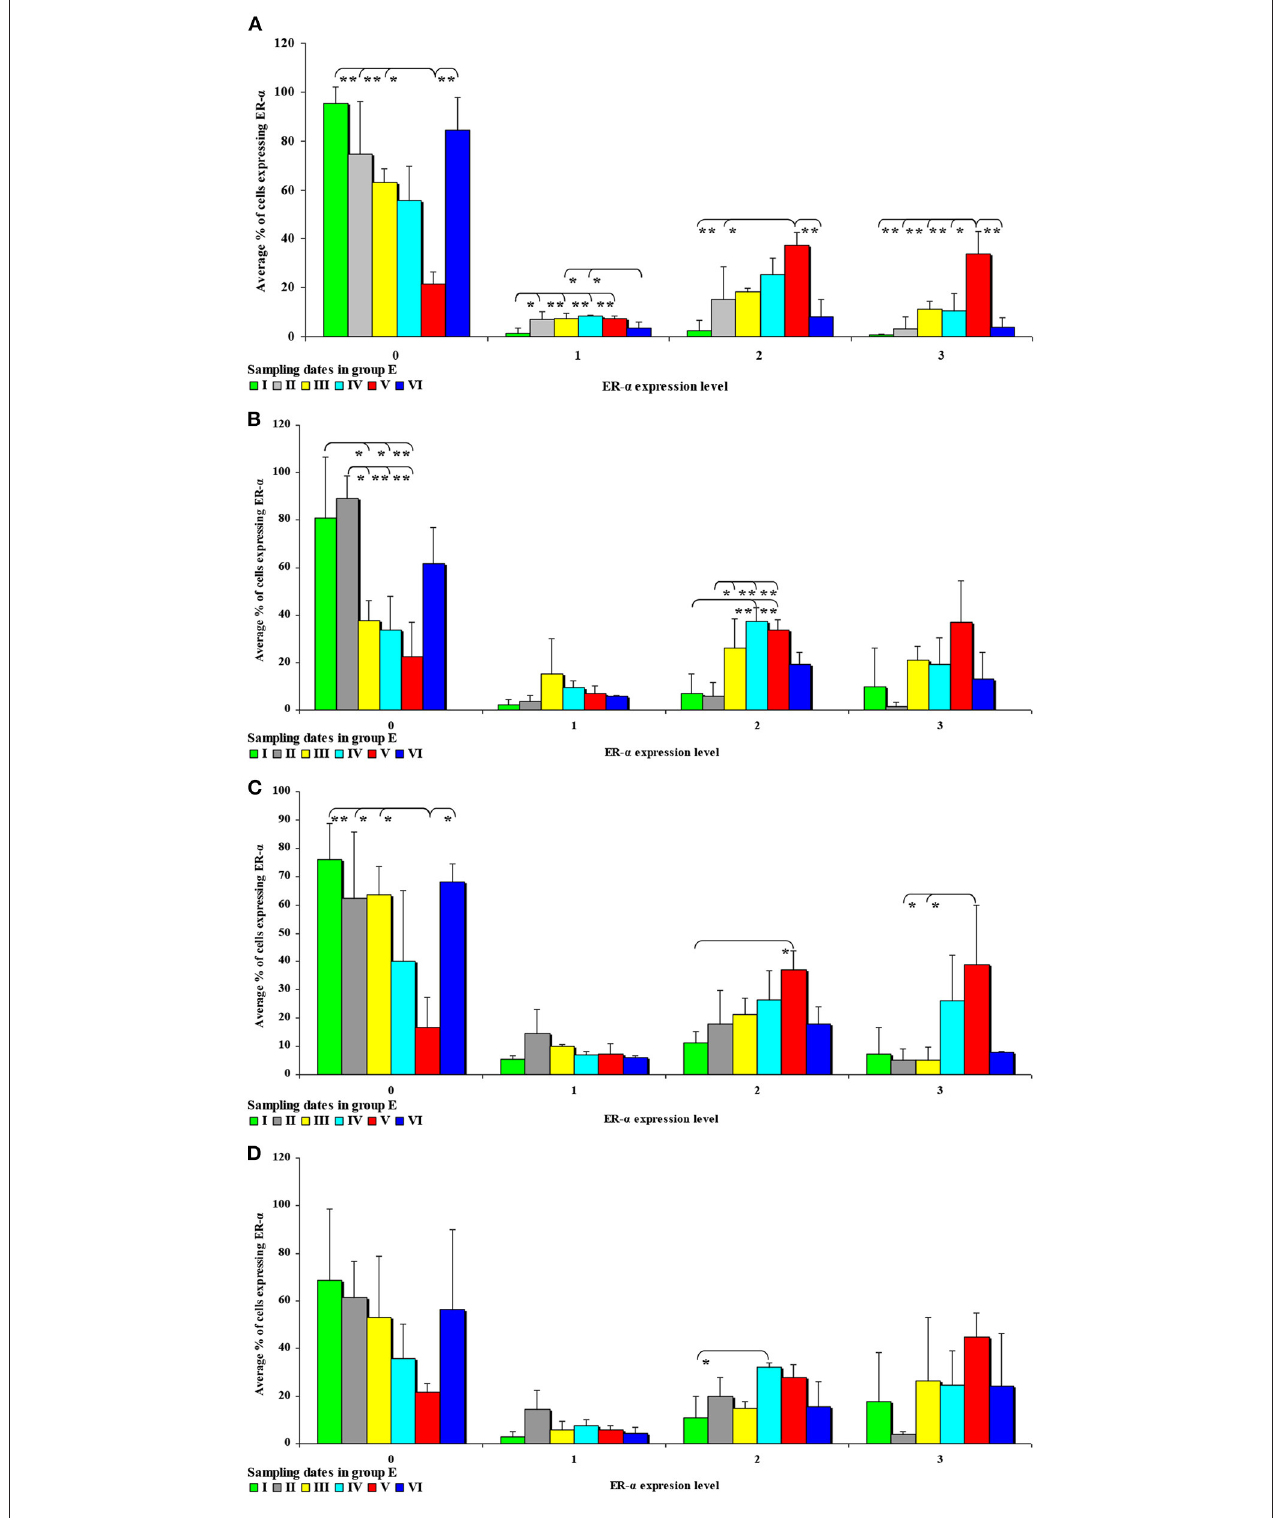
FIGURE 7 | The effect of DON on the immunohistochemical expression of ER α (graded on a 4-point scale: negative = 0 points; weak and homogeneous = 1 point; mild or moderate and homogeneous = 2 points; intense or strong and homogeneous = 3 points) in the intestines of pre-pubertal gilts from group E: (A) in the duodenal cap in selected weeks of exposure; (B) in the third part of the duodenum in selected weeks of exposure; (C) in the jejunum in selected weeks of exposure; (D) in the ascending colon in selected weeks of exposure. ER α expression is presented as mean values ( ± ) and standard deviation (SD) in selected samples. * P ≤ 0.05 and ** P ≤ 0.01 compared with the remaining